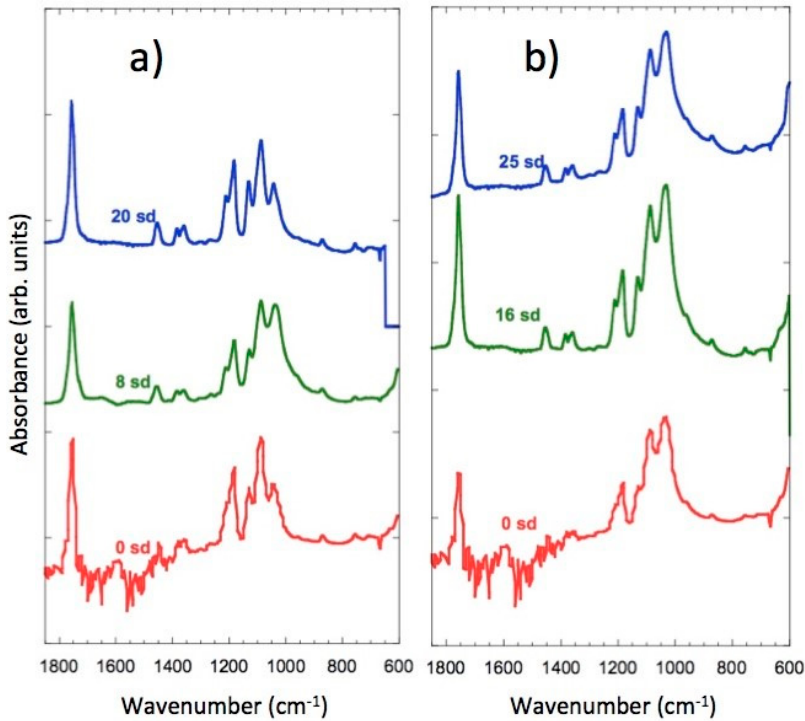
Figure 9. FTIR spectra of: ( a ) FeHA, PLLA/FeHA 30 wt % as prepared and after 8 and 20 weeks degradation. ( b ) FeHA, PLLA/FeHA 70 wt % as prepared and after 16 and 25 weeks degradation.